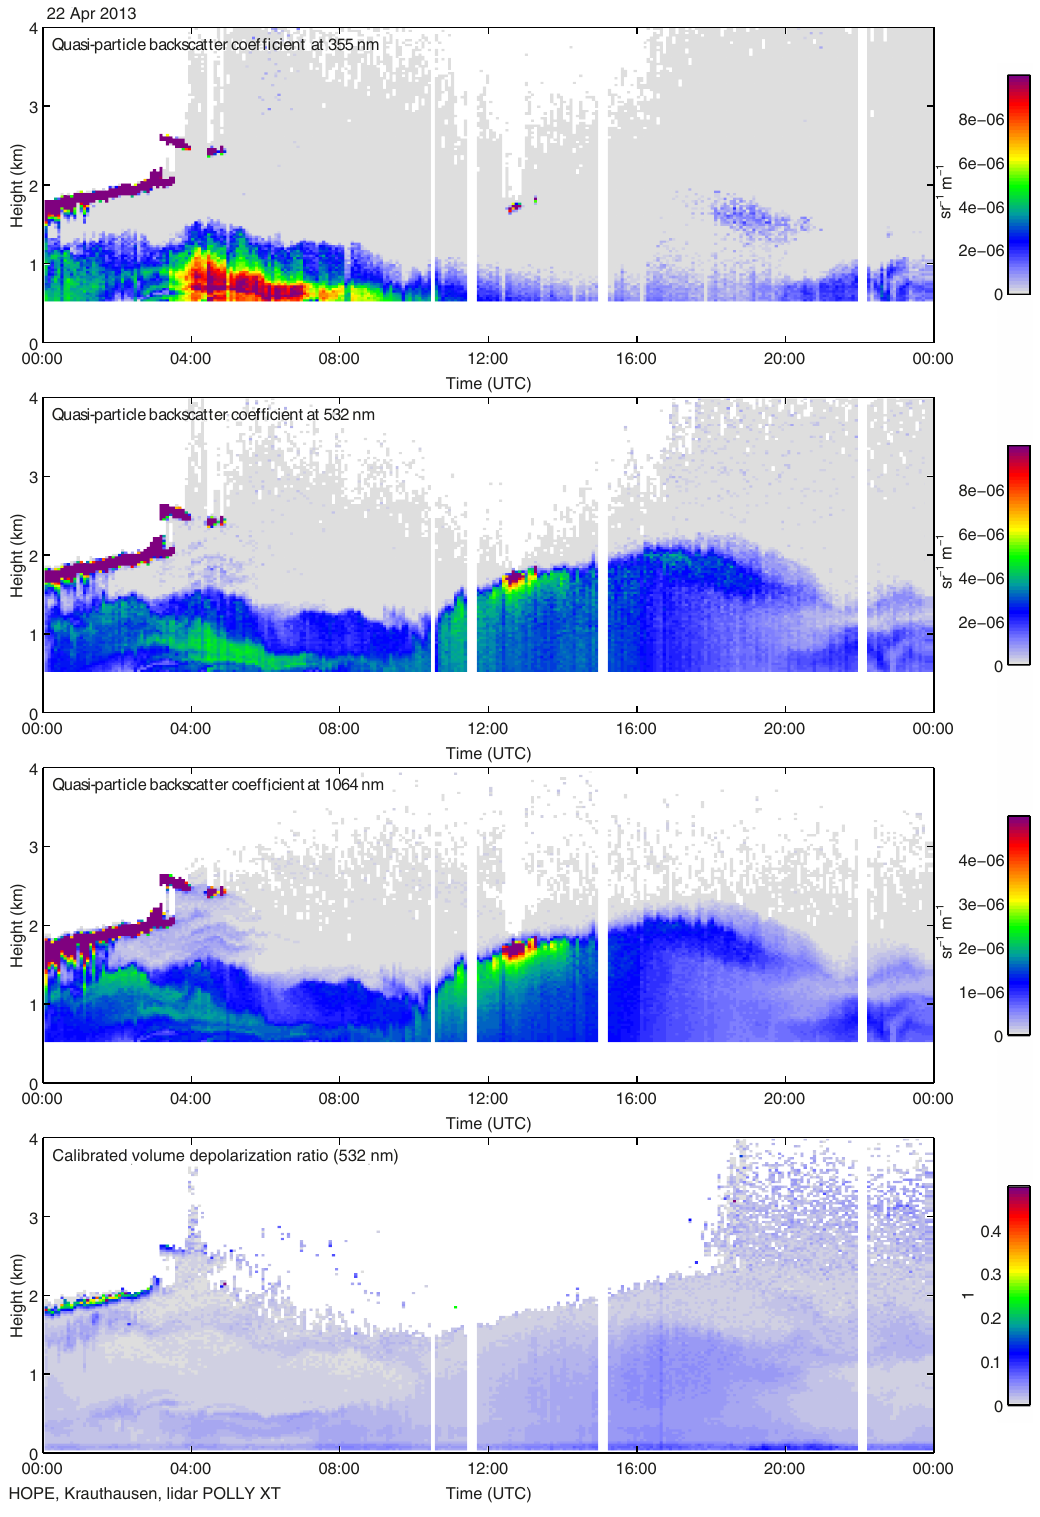
Figure 3. Polly observations at Krauthausen on 22 April 2013. Extensive properties from top to bottom: quasi-particle-backscatter coefficient at 355, 532, and 1064nm, and volume depolarization ratio at